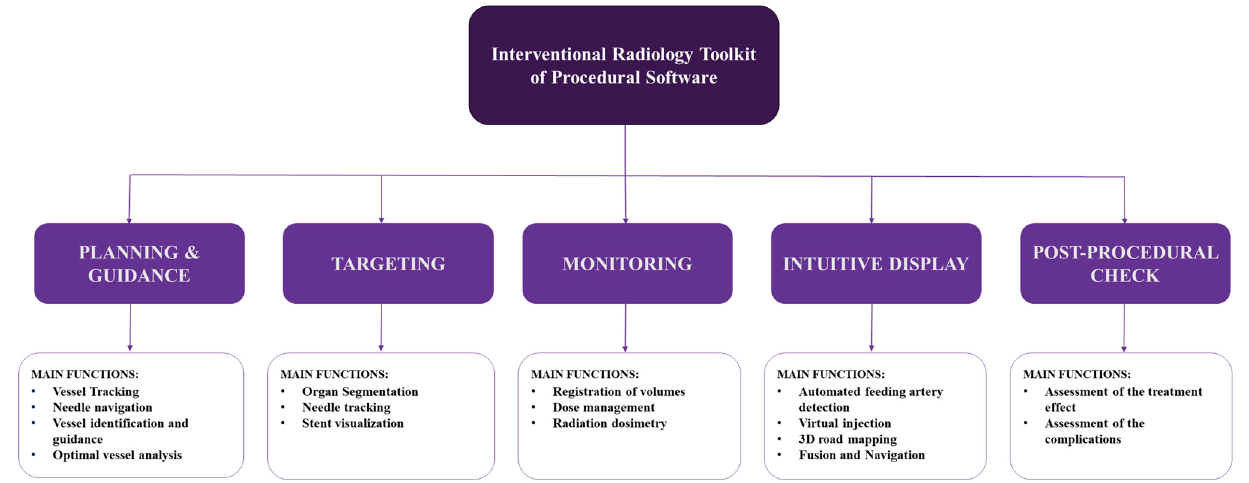
Figure 1. Flow diagram derived from Linte et al. and Floridi et al. [8,9] and algorithmicized by Al-Sharydah et al. to classify the Interventional Radiology toolkit of procedural software.